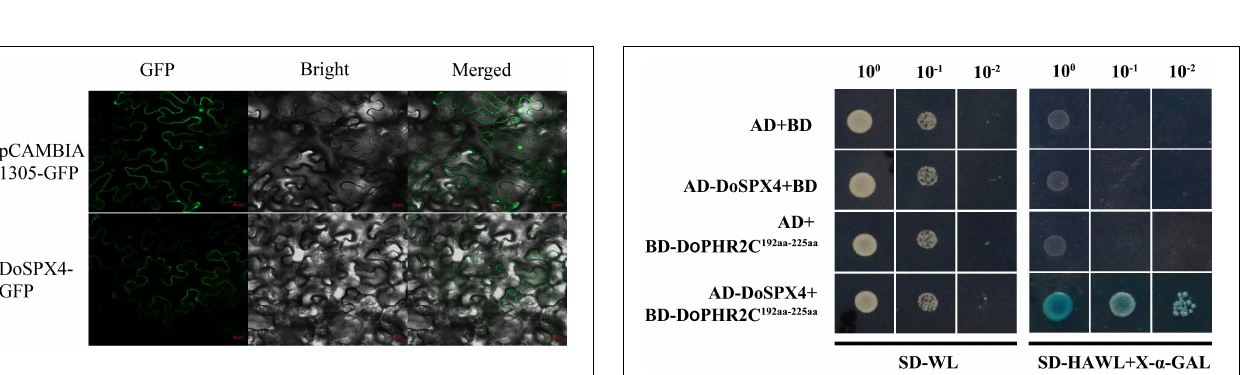
in Figure 3 . DoSPX1 and DoSPX4 showed similar expression patterns in various tissues and had high expression levels in D. officinale . DoSPX3 had high expression level in sepals, showed that DoSPX 3 played an important role in the sepals. DoSPX - EXS1